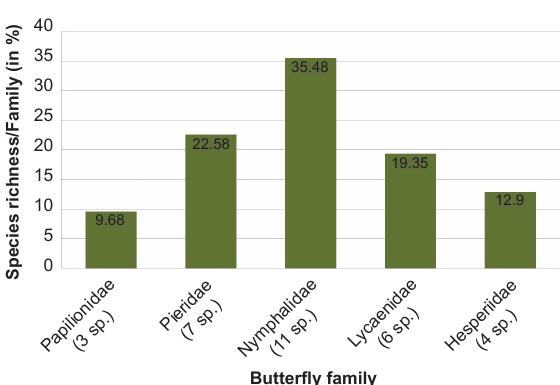
Figure 2. Incidences of butterfly species attracted to light in accordance with months (1951–2009), showing maximum records during the monsoon